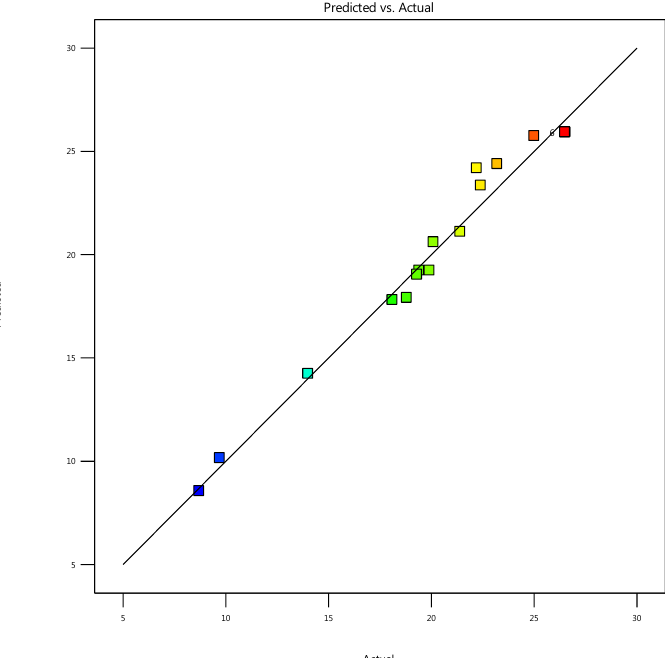
Figure 3. Predicted versus actual viscosity of